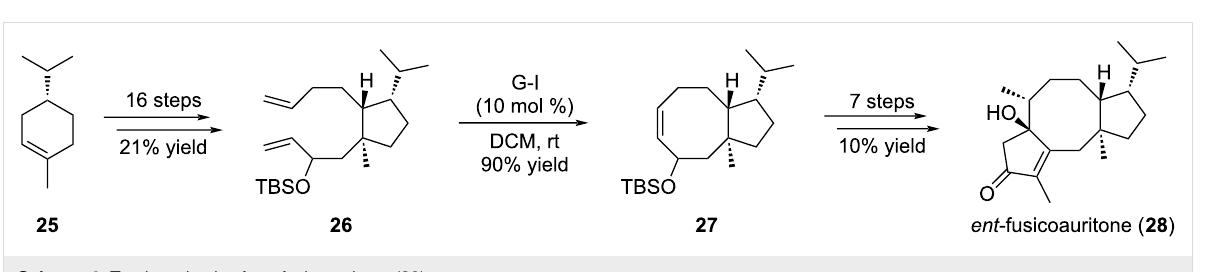
Scheme 4: Total synthesis of ent -fusicoauritone ( 28